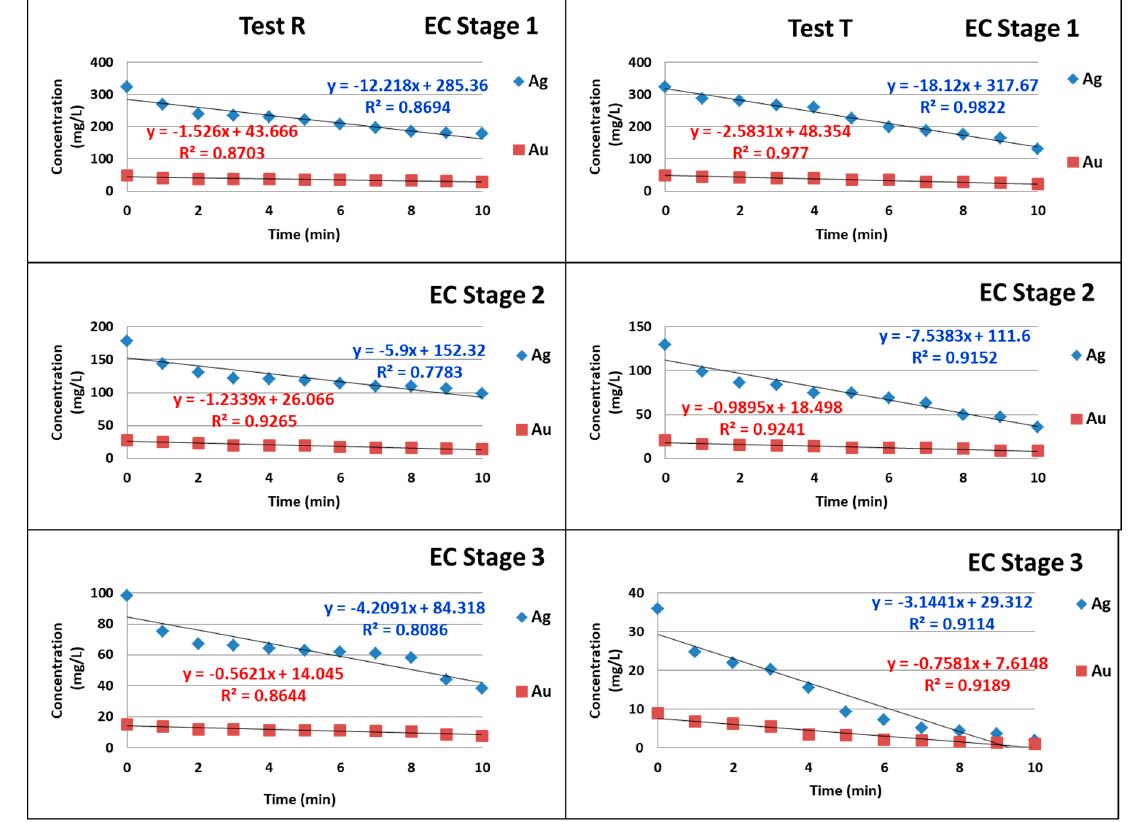
Figure 3. Concentration versus time, equations, and R 2 for tests R and T, according to stage.